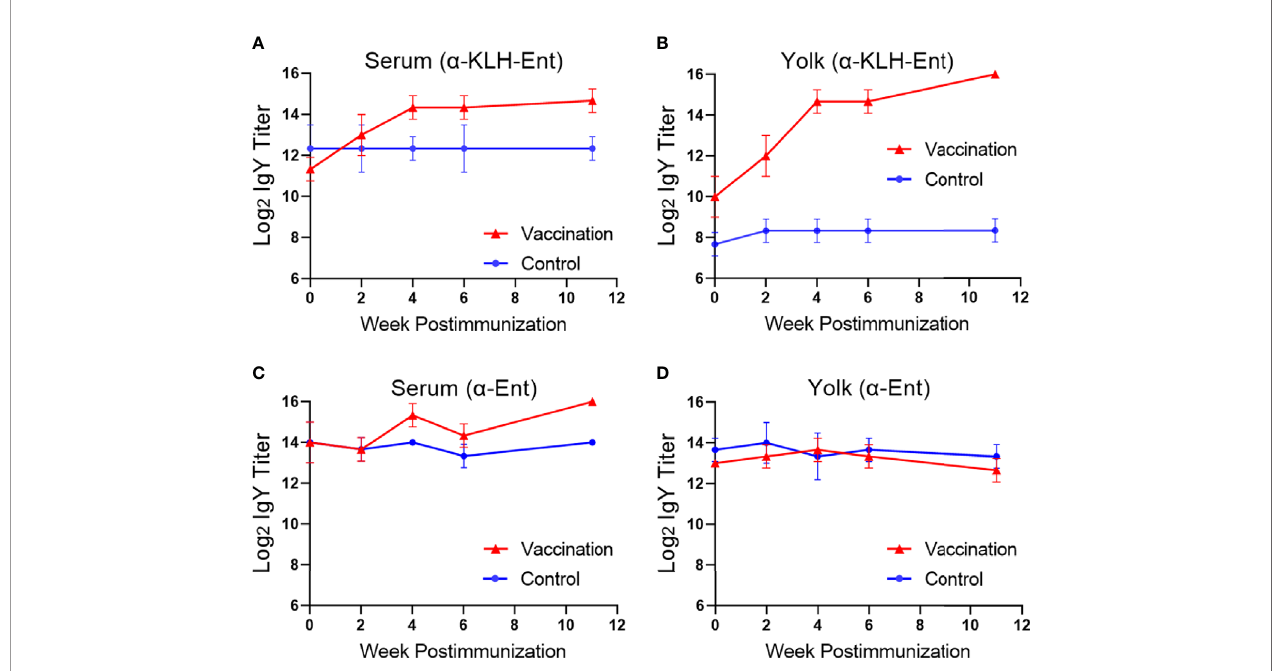
FIGURE 2 | Immune response of Barred Rock layers upon intramuscular immunization with the KLH-Ent conjugate (Trial #1). (A) Serum IgY titer against the KLH- Ent conjugate. (B) Egg yolk IgY titer against the KLH-Ent conjugate. (C) Serum IgY titer against Ent molecule. (D) Egg yolk IgY titer against Ent molecule. The chickens without receiving any immunizations served as negative control. Each point represents mean IgY titer ± standard deviation from three chickens with duplicate measurements within each